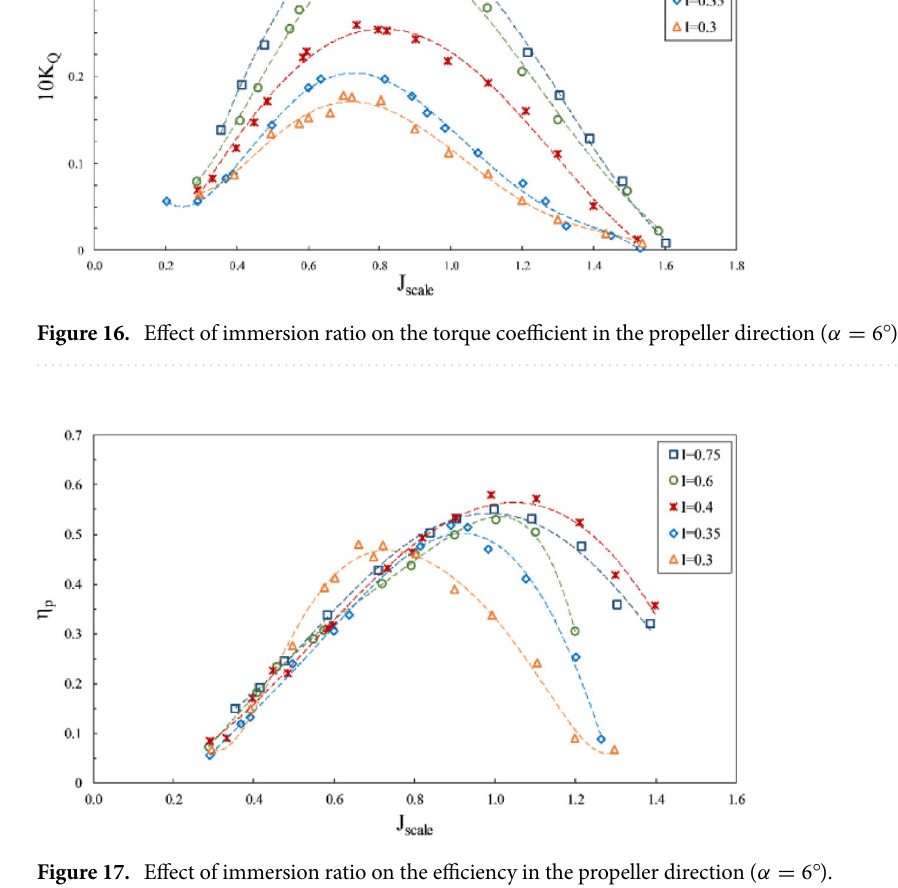
Figure 17. Effect of immersion ratio on the efficiency in the propeller direction ( α = 6 ◦